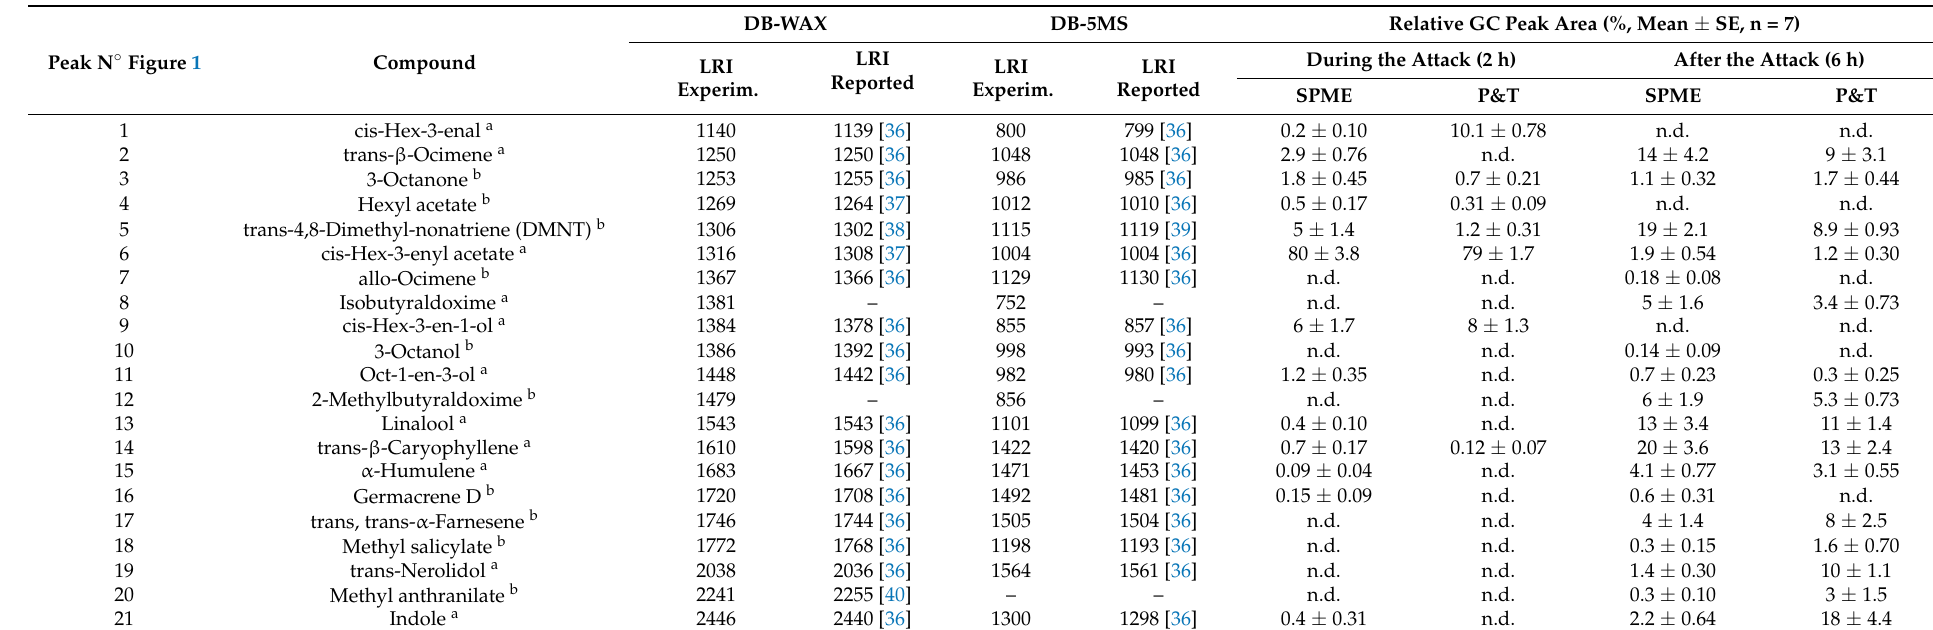
Table 1. Identification of volatile organic compounds emitted during and after herbivory of C . nitens